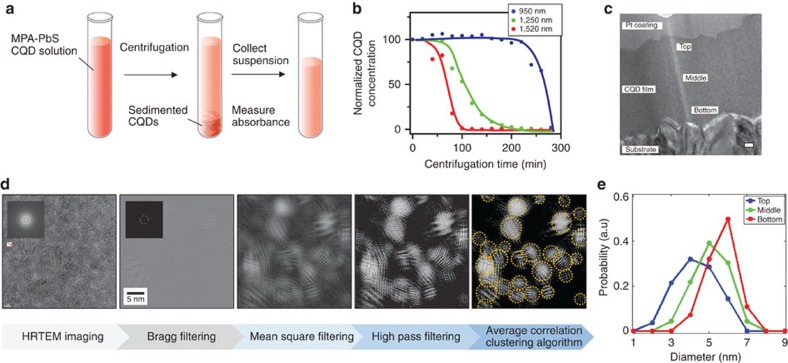
Experimental analysis of grading in CQD solids formed by C3.(a) Schematic of experiment used to measure sedimentation rates of CQD particles in solution during centrifugation. The solution was used with a mixture of three different-sized MPA–CQDs with excitonic peaks at 950, 1,250 and 1,520 nm. (b) Sedimentation rates of the particles were determined by measuring the change in the particle concentrations in the suspension from the absorbance. Absorption measurements recorded during centrifugation showed that particles of different sizes sediment at different rates, with the larger particles precipitating faster than smaller particles. Lines are added as a guideline for visualization. (c) A cross-sectional TEM image of the C3-created CQD film fabricated with the mixed solution of three different-sized MPA-CQDs with excitonic peaks of 950, 1,250 and 1,520 nm. The film was coated with Pt layer to avoid charging. (d) Image analysis algorithm for the quantitative recognition of the particle size in the high-resolution TEM images of MPA–PbS CQD structures (refer to Supplementary Note 1 for details). (e) Spatial size distribution of the MPA–PbS particle sizes in the film for locations from the top, middle and bottom of films.